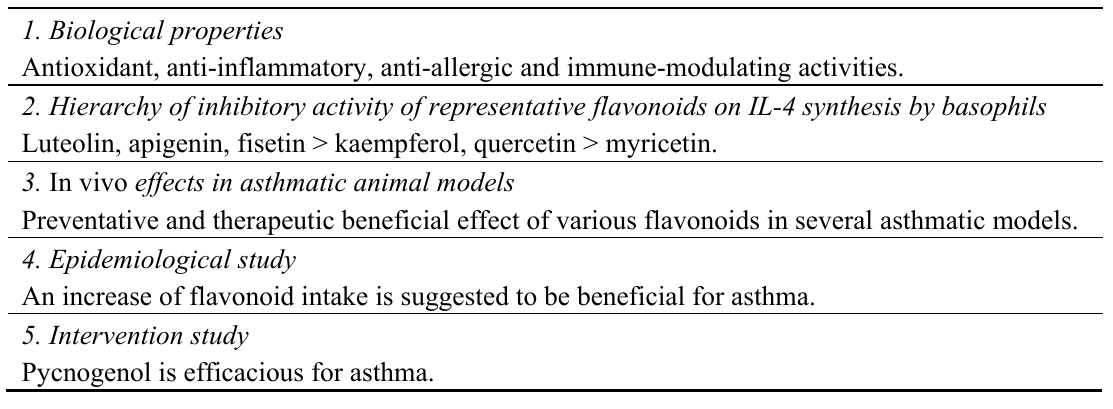
Table 1. Summary of anti-asthmatic effects of